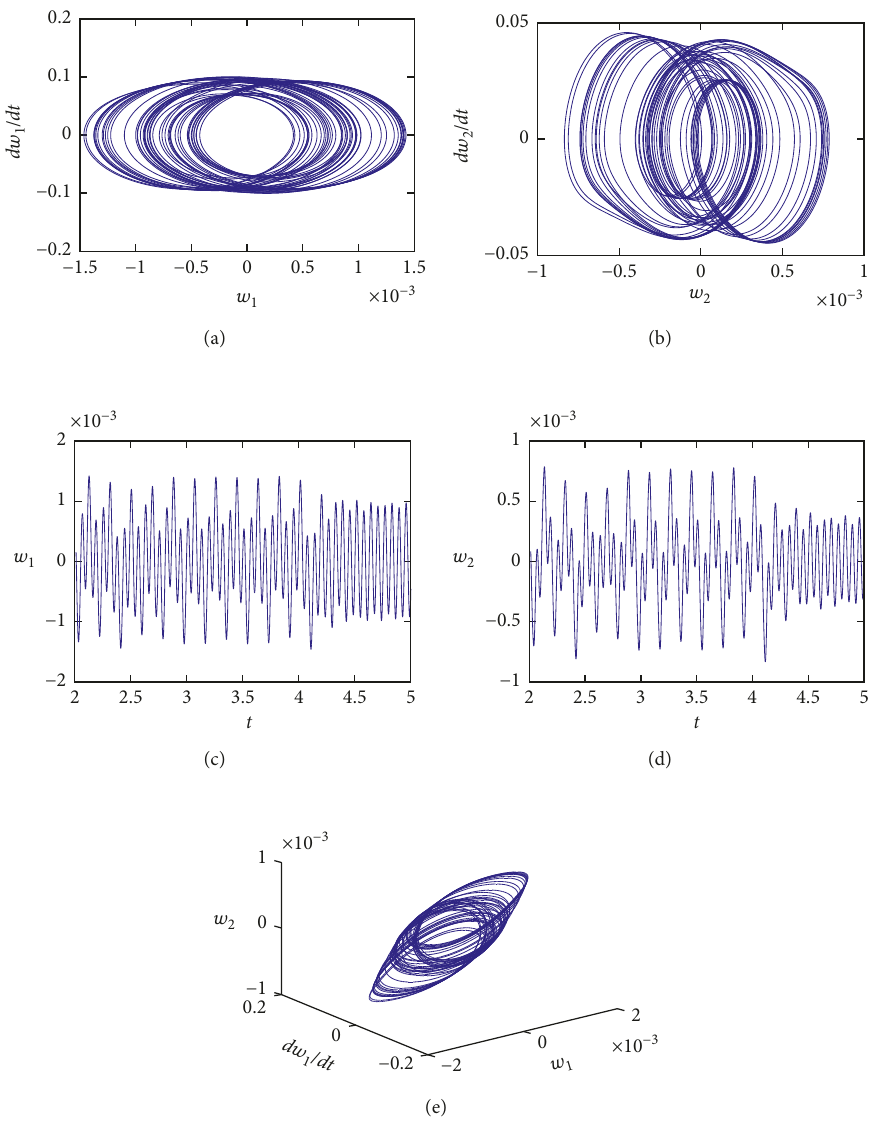
Figure 3: Chaotic motion of the cantilever honeycomb sandwich